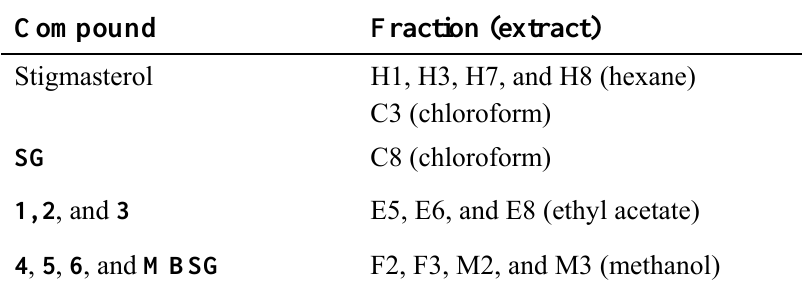
Table 1 . Isolated compounds from the fractions of the extracts.